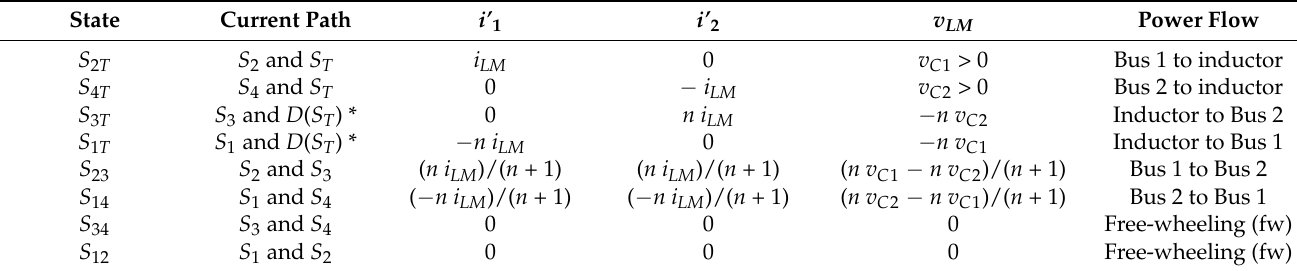
Table 1. Possible states of operation.